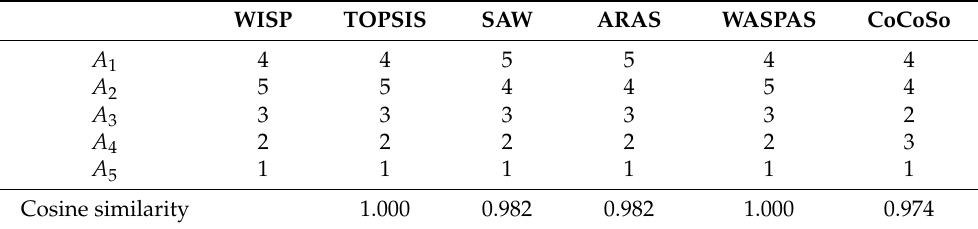
Table 8. The ranking orders obtained based on the third decision-making matrices. WISP TOPSIS